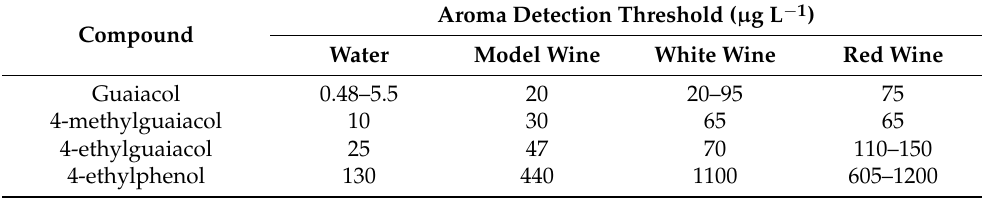
Table 2. Aroma detection thresholds for guaiacol, 4-methylguaiacol, 4-ethylguaiacol, and 4- ethylphenol